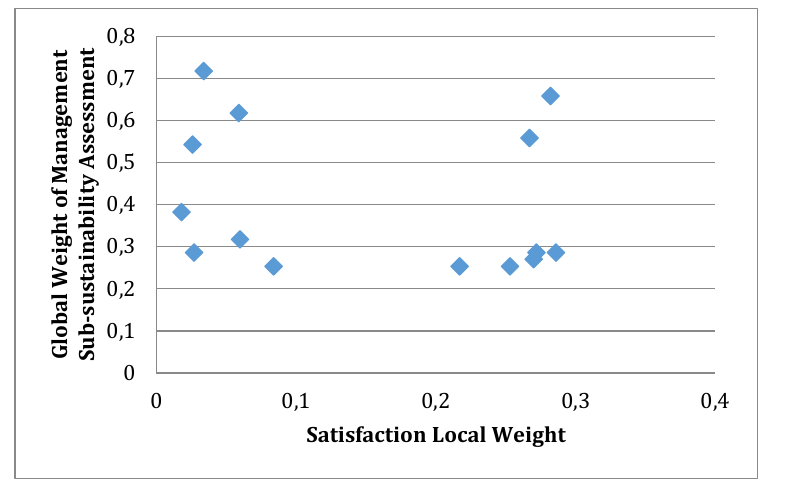
Figure 30: Global weight vs. satisfaction local weight of management sub-sustainability